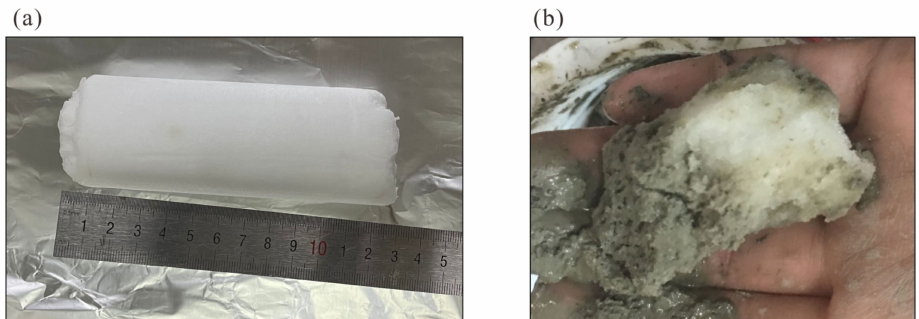
Figure 3. Photos of cylindrical ice powder ( a ) and a part of massive hydrate ( b